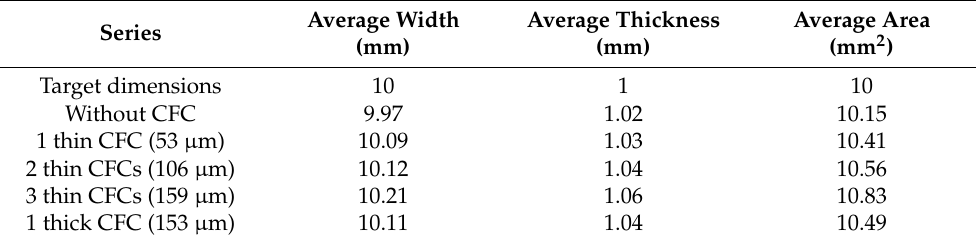
Table 2. Studied CFC compositions based on the manufacturer’s data, and the target and measured average dimensions of the sample